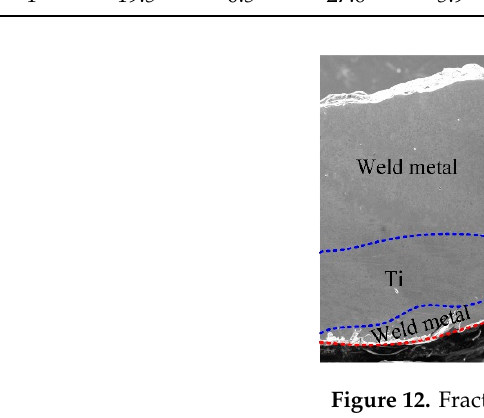
Figure 11. Fracture morphology of joints; ( a ) Joint I (sample #1), ( b ) Joint II (sample #2) and ( c ) Joint III (sample #3). Table 7. EDS analysis results of fracture morphology for Joint I (specimen #1) in Figure 11 (at. %). Point.